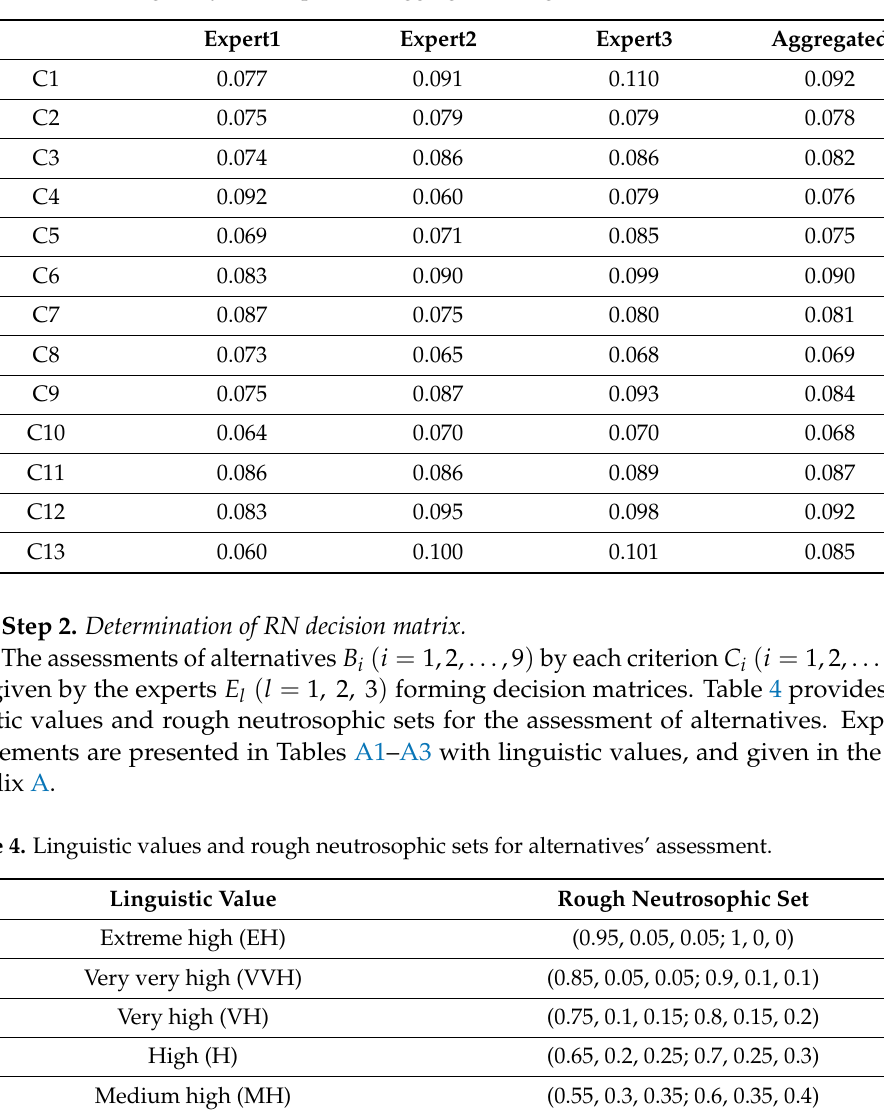
Table 3. Criteria weights by each expert and aggregated weights.